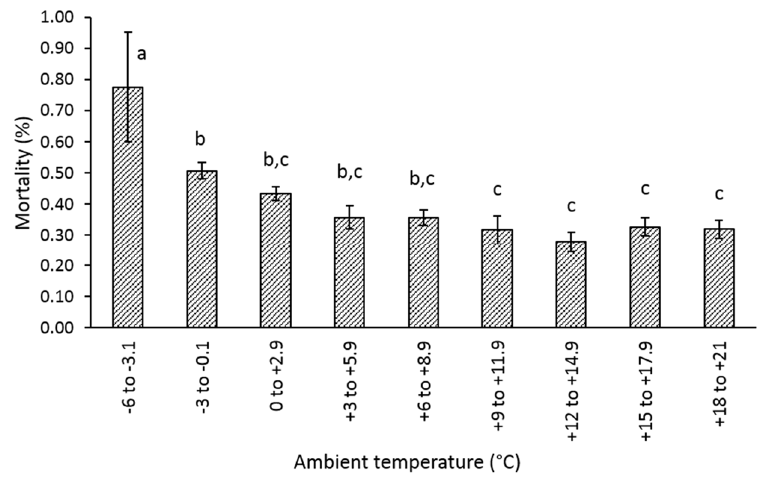
Figure 4. Transport-related mortality of broiler chickens as affected by the ambient temperature (mean±standard error of the mean). a,b,c Means with different superscripts differ significantly